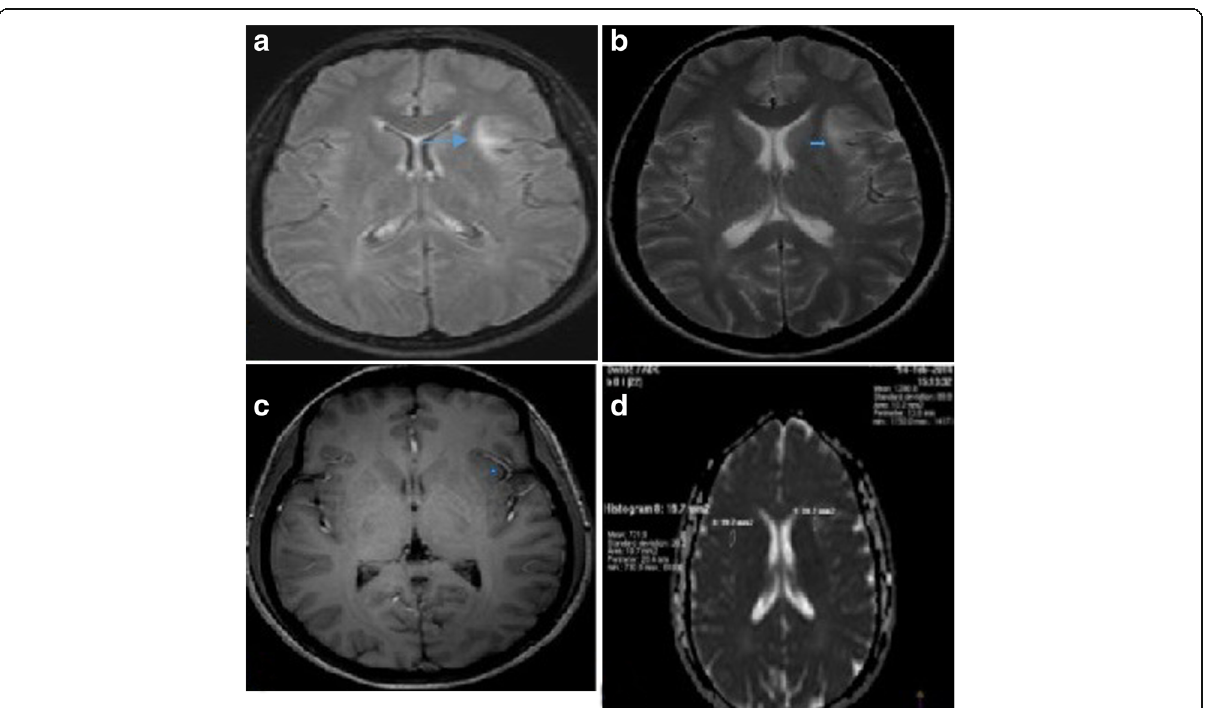
Fig. 5 A 21-year-old female patient with epilepsy. a Subcortical hyperintensity in axial FLAIR sequence. b Increase in cortical signal intensity in axial T2A sequence and subcortical blurring. c Cortical thickening in axial T1A sequence. d Hyperintense area in axial dADC sequence, ADC measurement from this area and from a symmetrical area